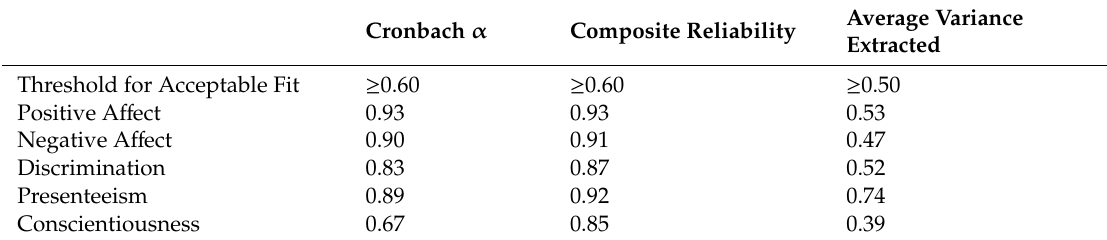
Table 3. Measures of local fit for the modified